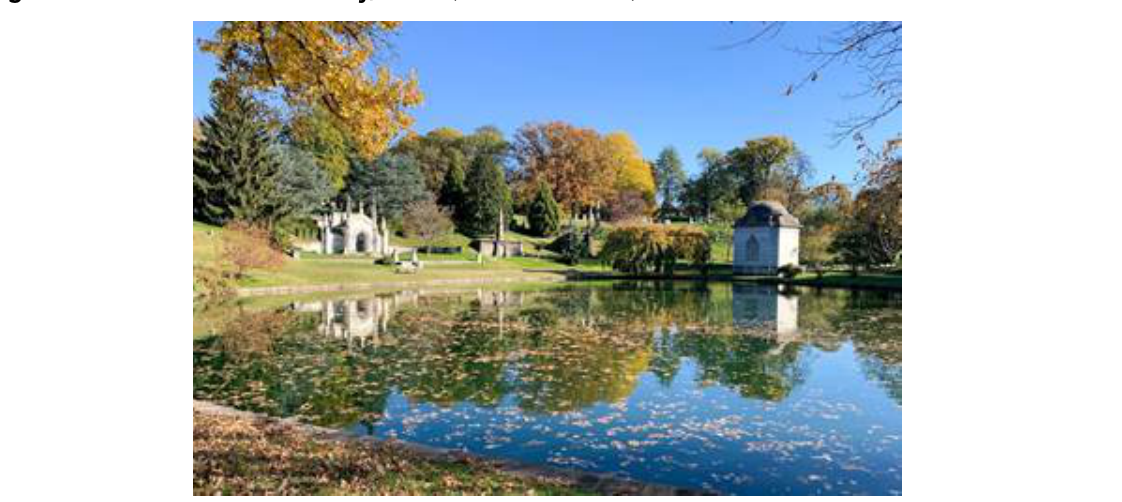
Figure 4. Green-Wood Cemetery, 2021 (Source: author)